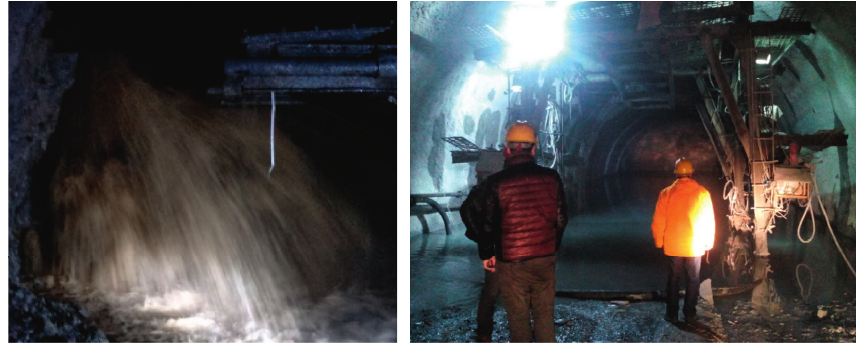
Figure 12: Photos of water gushing from actual excavation to K42